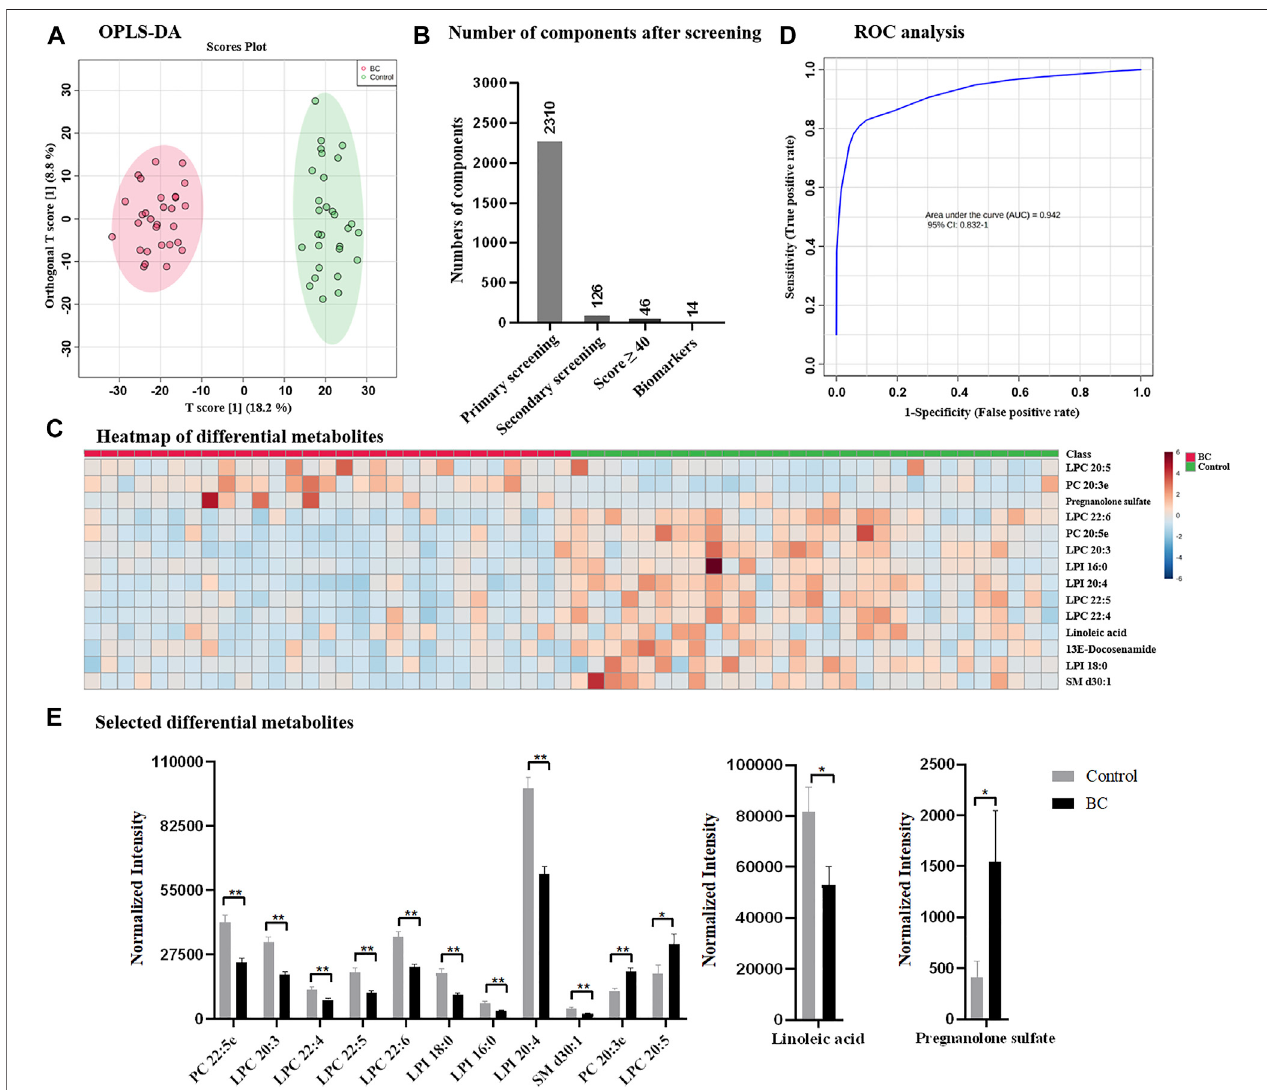
FIGURE 3 | (A) OPLS-DA score plots derived from the serum metabolomics datasets collected from healthy control and breast cancer group; (B) number of components after designed screening steps; (C) heatmap ofdifferential metabolites; (D) ROCanalysis; and (E) selected differential metabolites between healthy control and breast cancer group. BC: breast